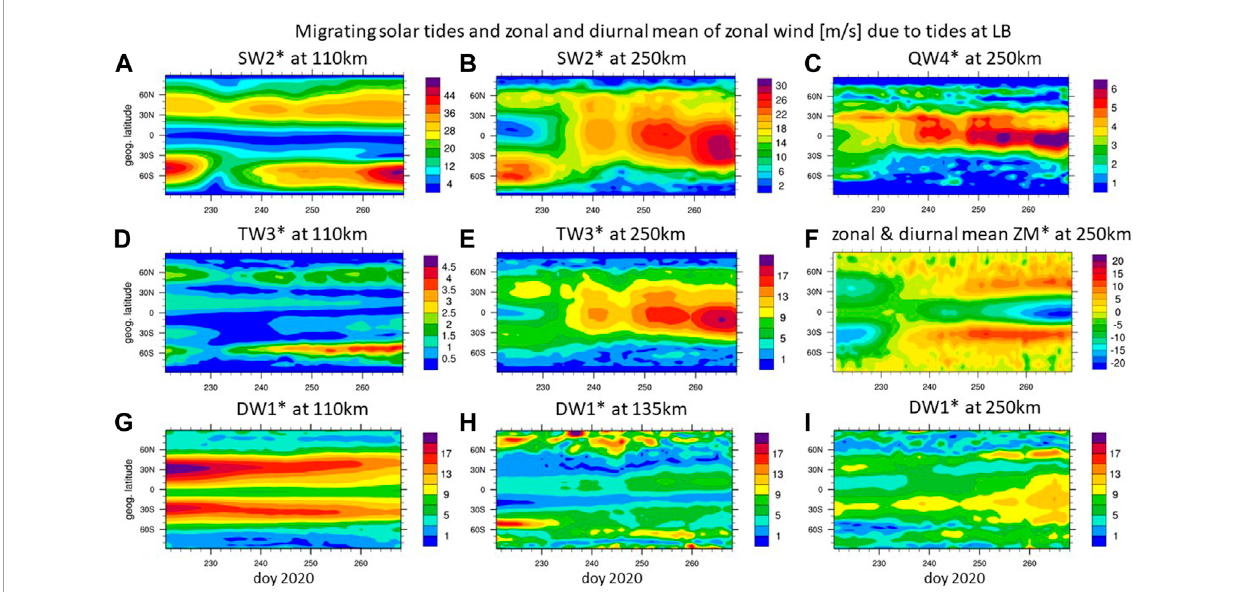
FIGURE 4 Amplitudes of migrating solar tides in zonal wind [m/s] only due to tides at lower boundary (LB) in (A) . SW2 at 110 km and (B) . SW2 at 250 km, (C) . QW4 at 250 km, (D) . TW3 at 110 km and (E) . TW3 at 250 km, (G) . DW1 at 110 km, (H) . DW1 at 135 km, and (I) . DW1 at 250 km, and (F) . zonal and diurnal mean zonal mean wind at 250 km over geographic latitude and day of year (DOY)